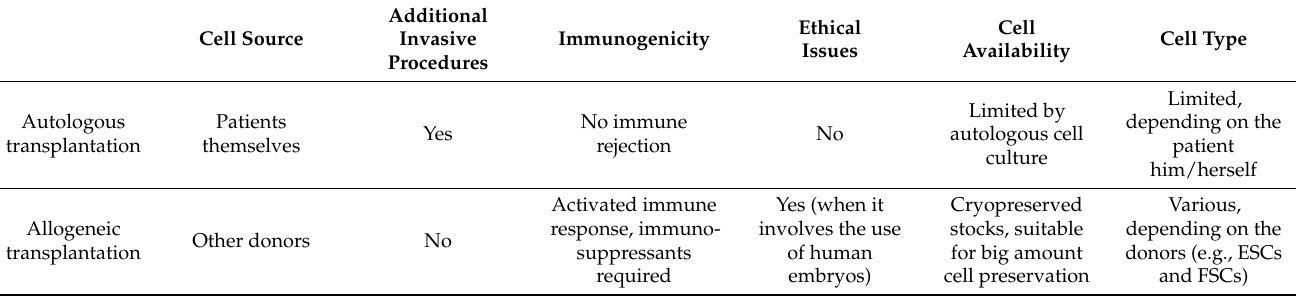
Table 1. Differences between autologous transplantation and allogeneic transplantation. Cell